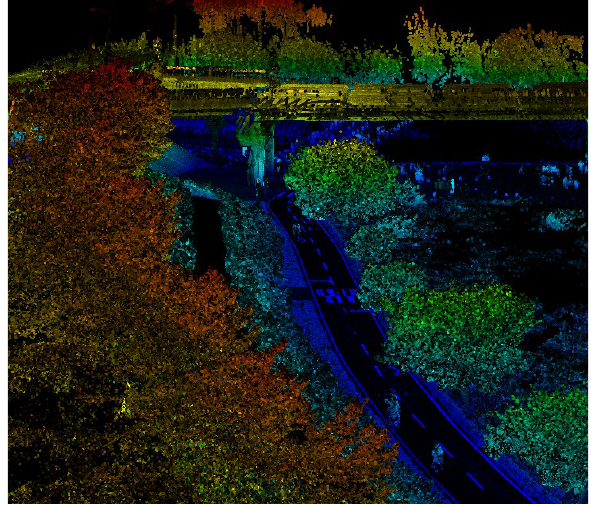
Figure 1. Pointcloud of test site (colors represent height)